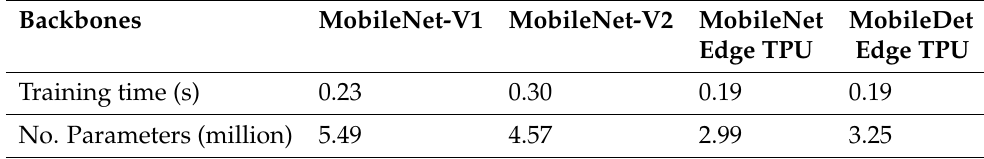
Table 1. The total number of parameters and the training duration for one